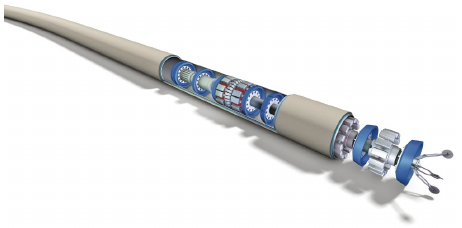
Figure 1. Smart Pipeline Inspection Gauge (Nord Stream AG).